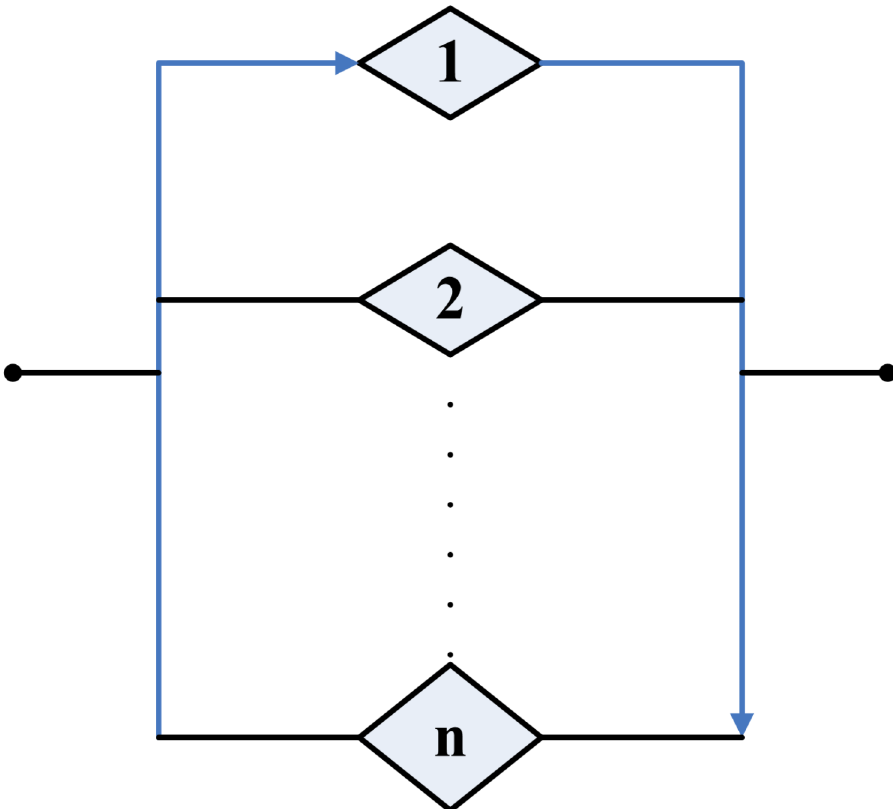
Fig. 3 Parallel system